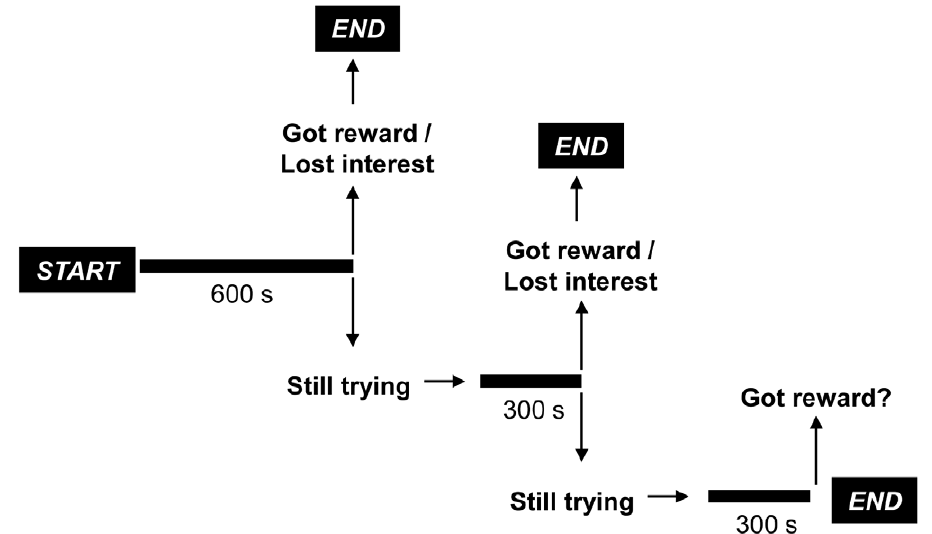
Figure 1. Schematic illustration of the procedure used in Experiment 1and 2.